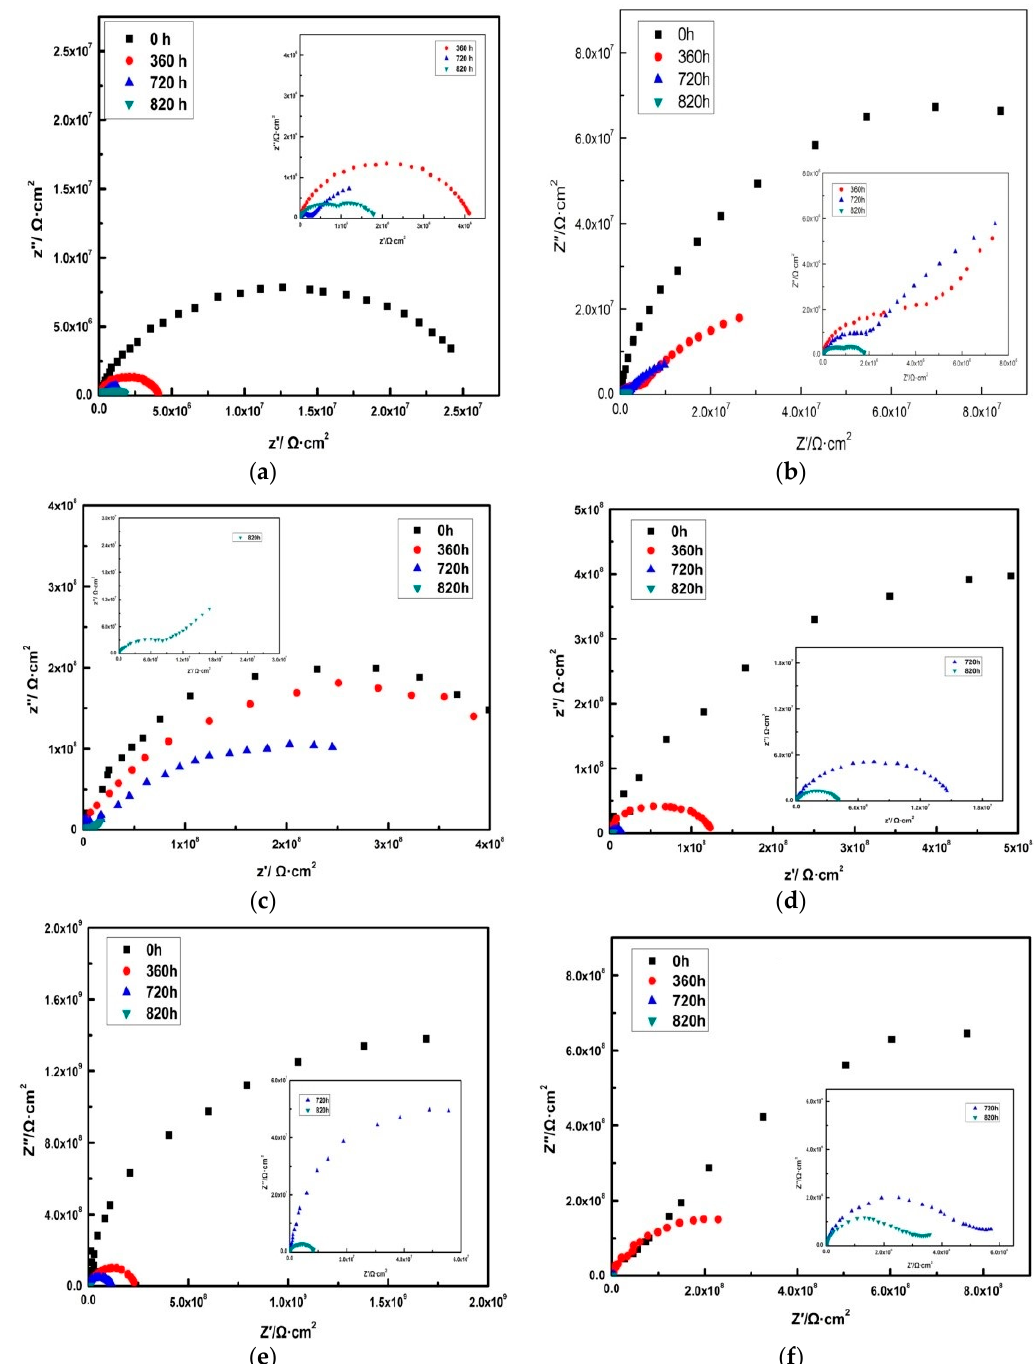
Figure 7. Nyquist diagrams of the six coatings in different immersiontime: ( a ) pure epoxy coating; ( b ) 1.0% meso-TiO 2 coating; ( c ) 0.5% DA/meso-TiO 2 coating; ( d ) 0.7% DA/meso-TiO 2 coating; ( e ) 1.0% DA/meso-TiO 2 coating; and ( f ) 2.0% DA/meso-TiO 2